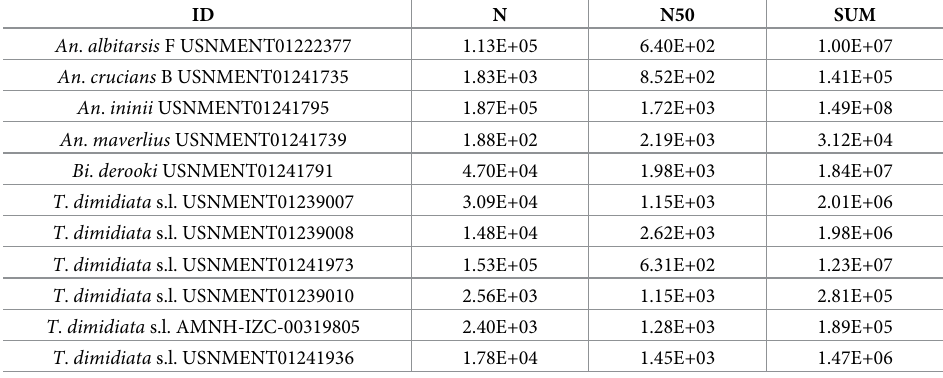
Table 4. Summary statics for the genome assembly of each specimen: Total contigs in the assembly (N), contiguity of the assembly (N50), sum of contig lengths (SUM). ID N